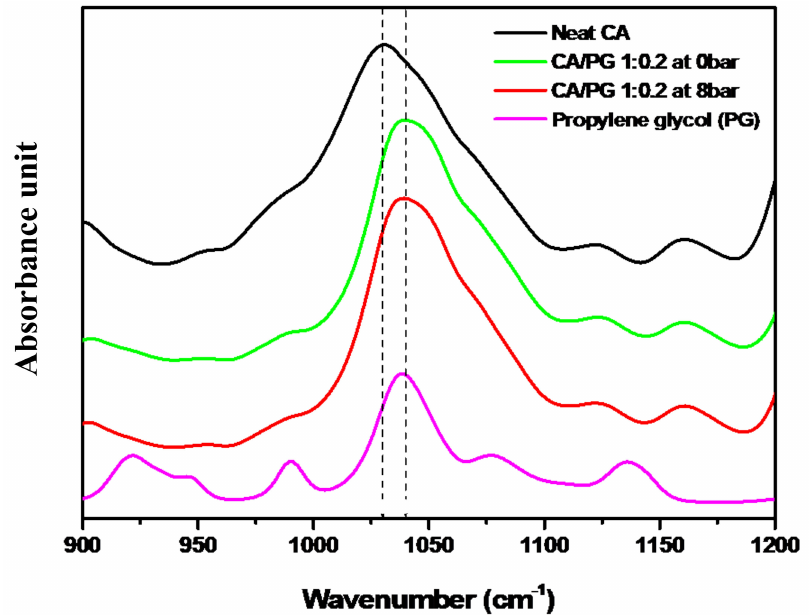
Figure 2. FTIR spectra showing the ether group of neat CA, 1:0.2 CA/propylene glycol (0 bar, 8 bar) and propylene